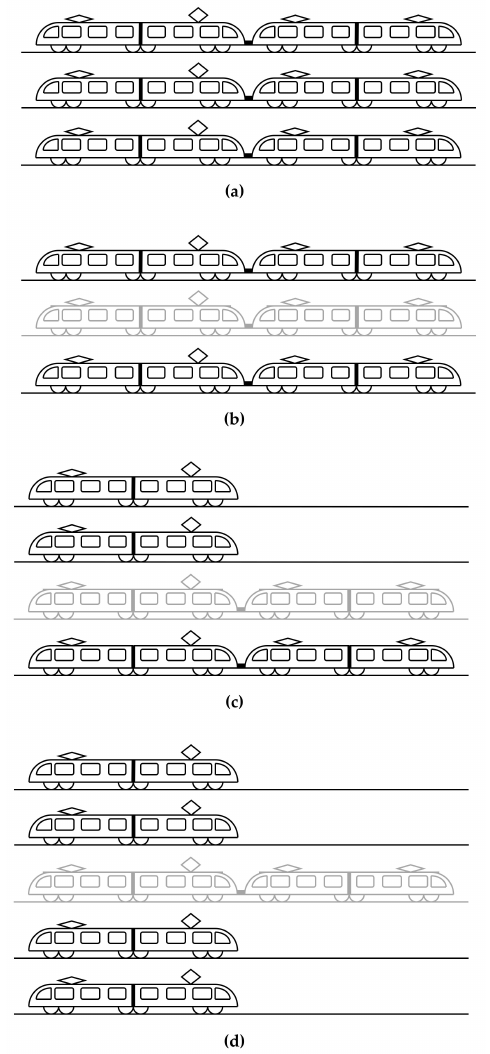
Figure 4. Service schemes in the case of rolling stock configuration 1: ( a ) ordinary service; ( b ) railcar unavailability without any intervention; ( c ) railcar unavailability with intervention for keeping the number of rail convoys unchanged; ( d ) railcar unavailability with intervention to increase the number of rail